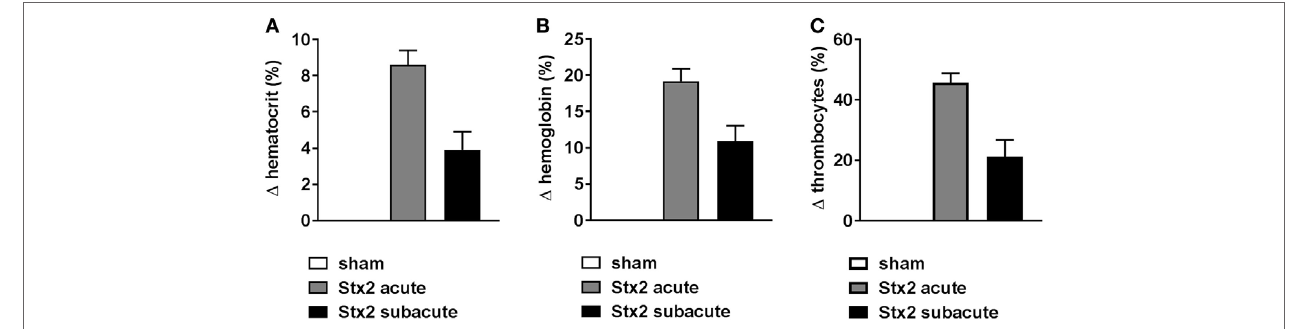
FigUre 3 | Hemoconcentration and thrombocytes in C57BL/6J mice subjected to different Stx2 regimens. Percentage change of (a) hematocrit, (B) hemoglobin, and (c) thrombocytes for the acute (sham n = 6, Stx2 n = 11) and subacute model (sham n = 5, Stx2 n = 6) compared with the respective sham group. (a–c) Data are expressed as mean ± SEM for n